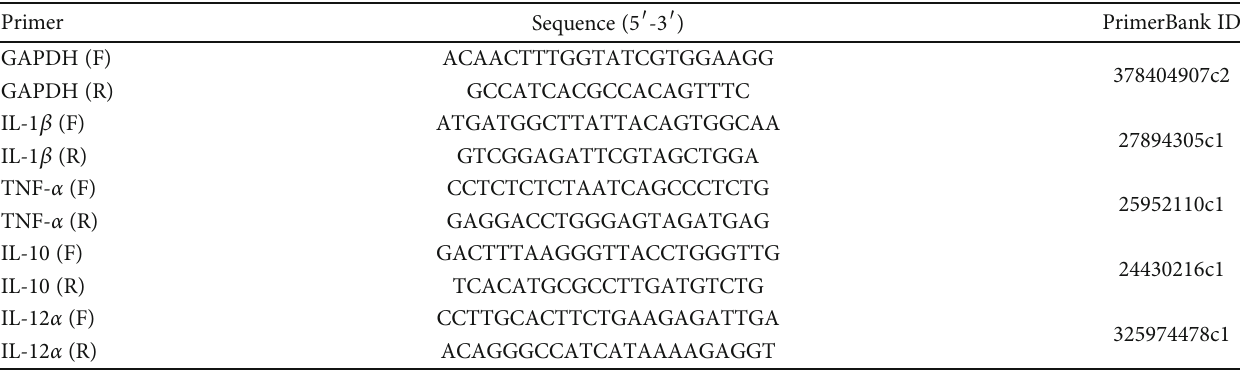
Table 2: Primers used for quanti fi cation of cytokine